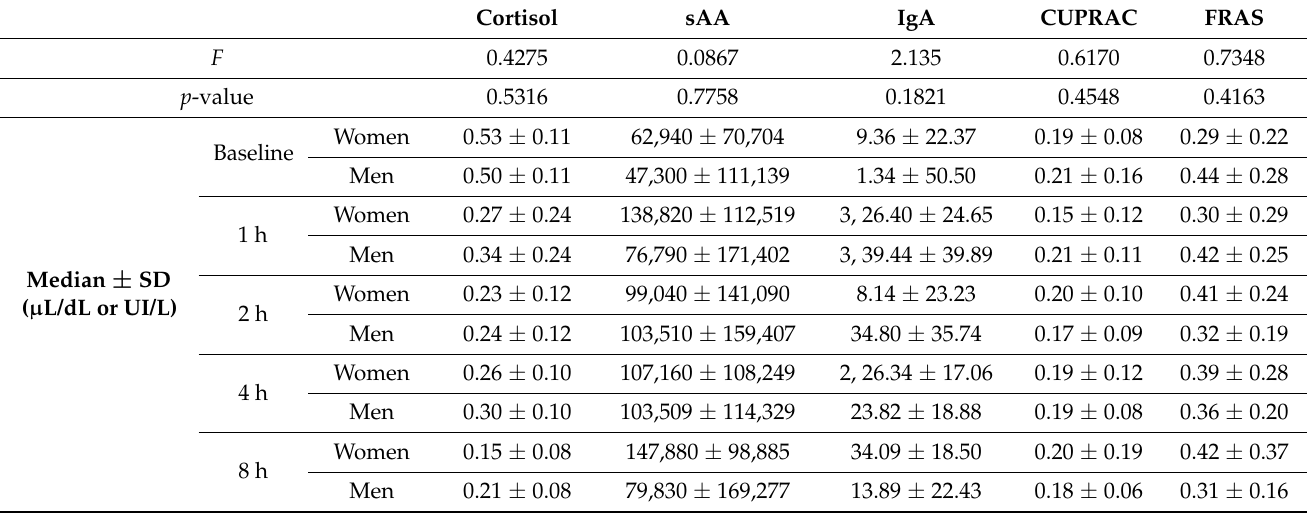
Table 1. Two-way ANOVA analysis results, median and standard deviation per gender and